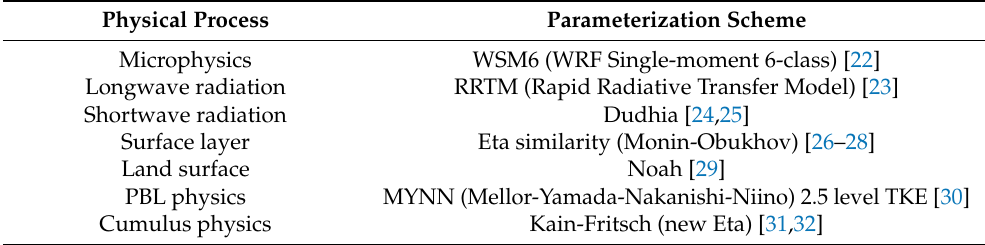
Table 1. Physical configuration used in the simulation.